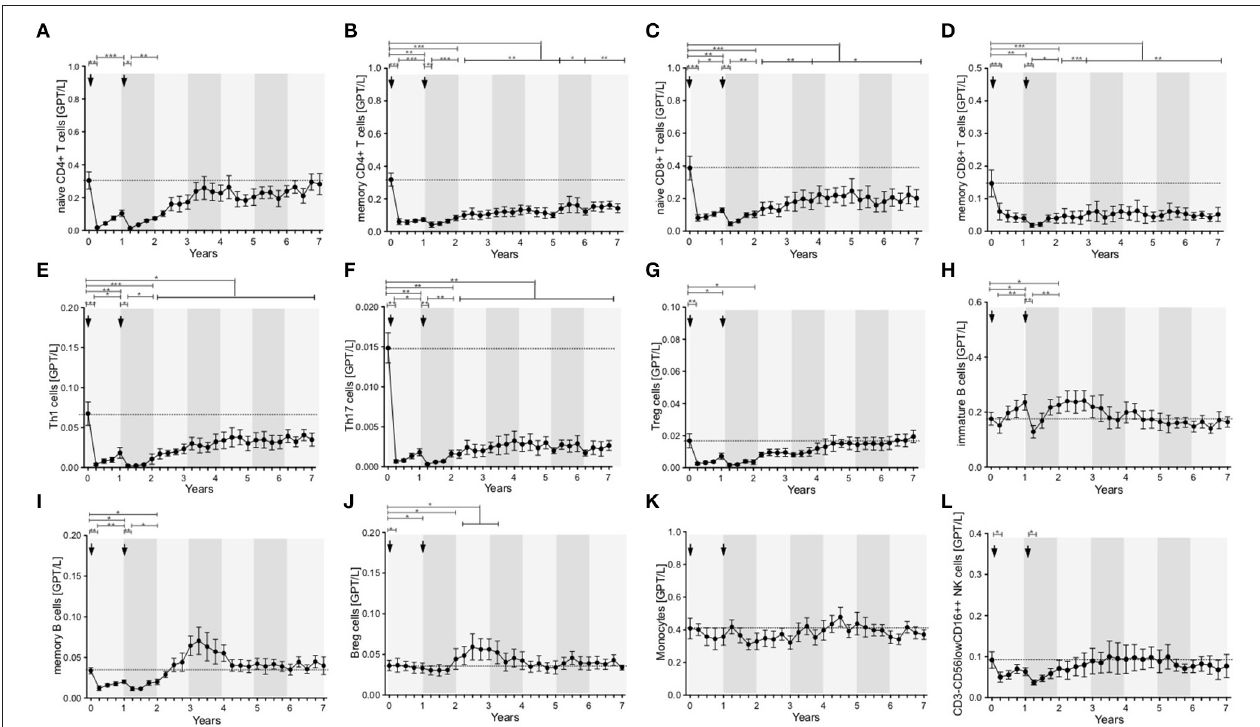
FIGURE 3 | Distribution of peripheral immune cell subsets of patients with stable disease course after 1st and 2nd ATZ (complete-responder). Distribution of absolute count of peripheral immune cell subsets before (0 years) and up to 7 years follow up are depicted. Mean values + / − SD of absolute count of T cell (A–G) , B cell (H–J) , and innate immune cell (K,L) subsets are shown. Asterisks indicate a statistically significant difference (* p < 0.05, ** p < 0.01, *** p < 0.001).